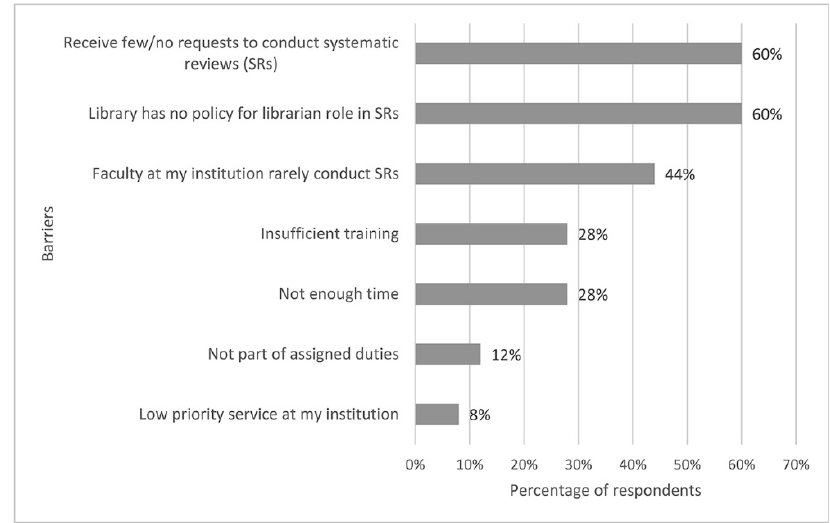
Figure 2 Barriers to veterinary librarian participation in systematic and scoping